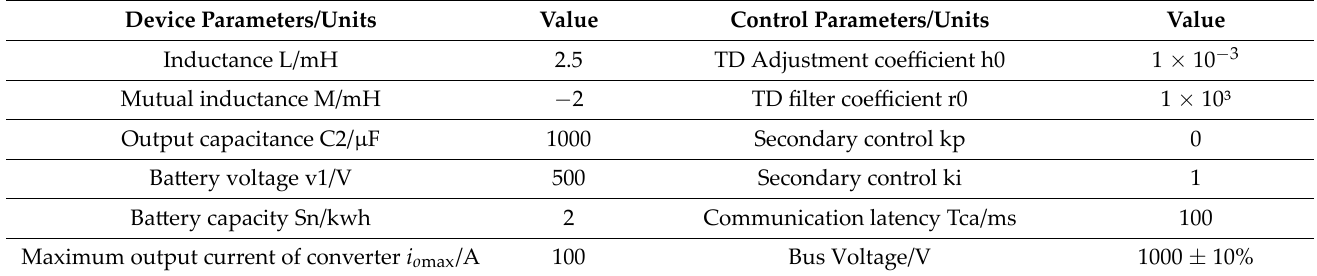
Table 1. Circuit and control parameters.